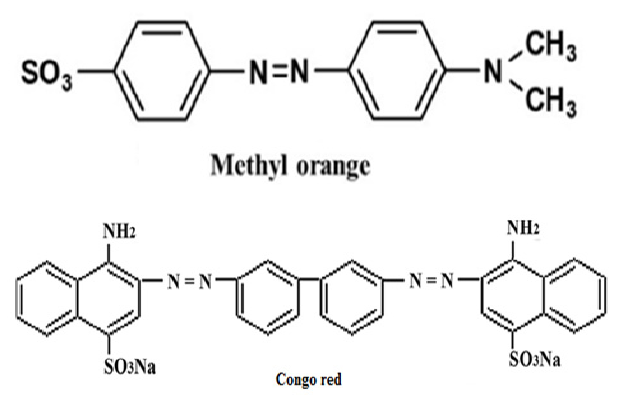
Fig. 1. The structural formula of Methyl orange and Congo red dye.